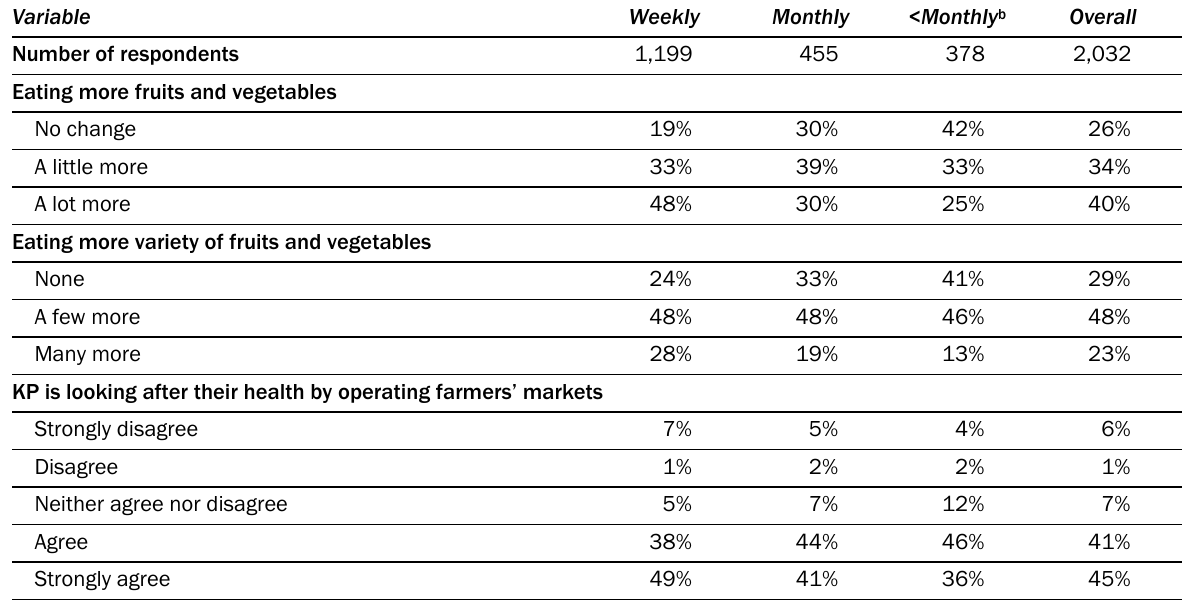
Table 2. Kaiser Permanente (KP) Farmers’ Market Survey: Change in Fruit and Vegetable Consumption, Perception of KP, by Frequency of Market Use